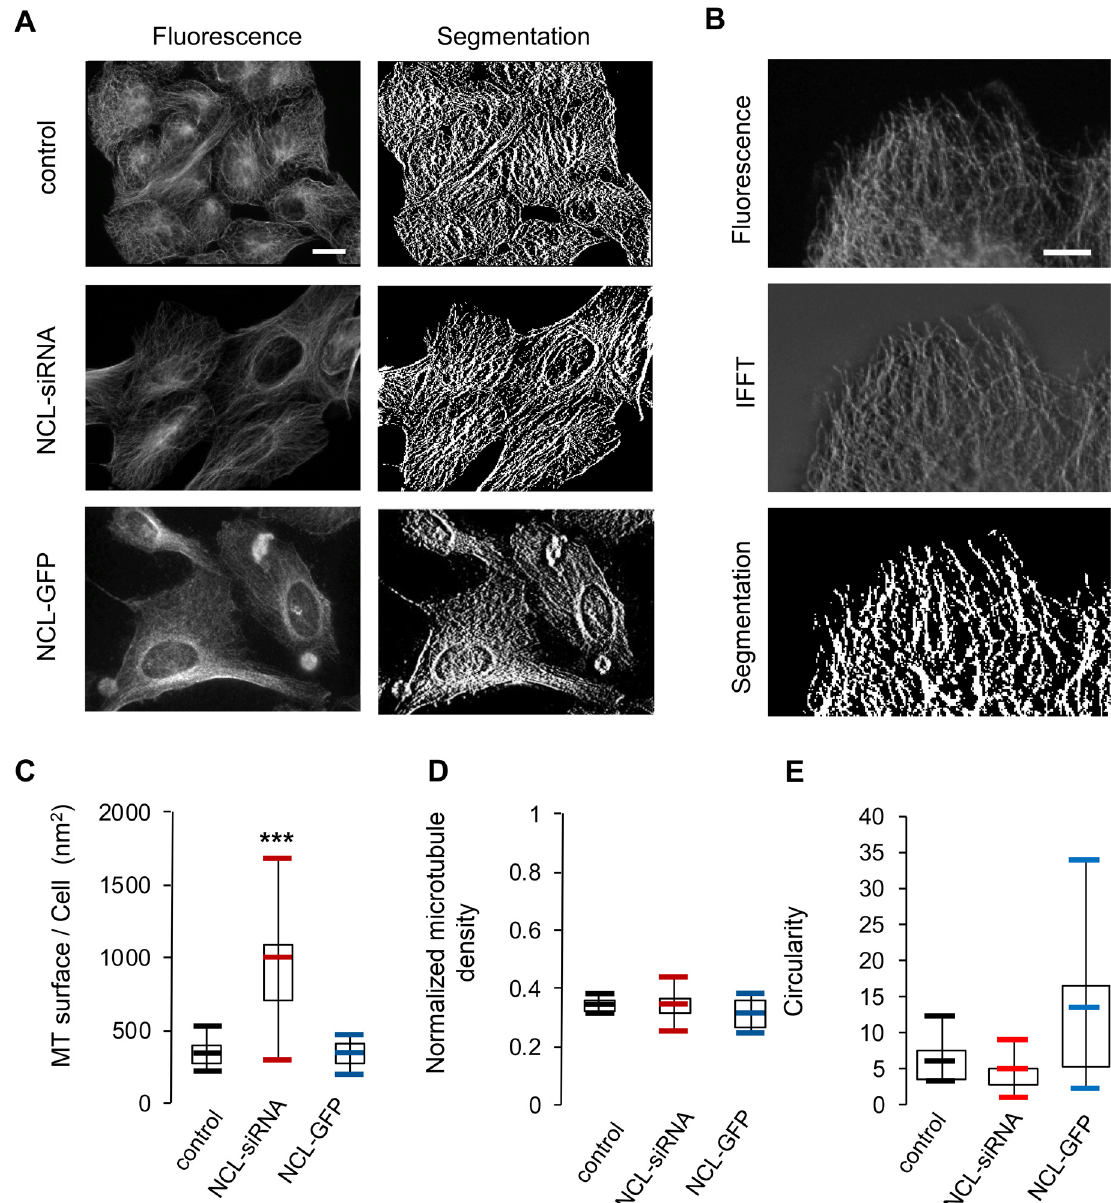
Fig 3. Nucleolin expression does not influence microtubules density. U2OS cells were either transfected with NCL-siRNA or NCL-GFP plasmid and after 4 days were fixed for tubulin immunofluorescence detection (A). The first column shows the immunofluorescence picture of the best focus image among the z-stack. The second column shows the segmentation picture. (B) Details of one control cell showing the different steps of the analysis IFFT: Inverse Fast Fourier Transform. Scale bars represent = 10 μ m. (C) Quantification of the microtubule surface per cell for control, NCL-siRNA and NCL-GFP cells. The asterisks indicate that the mean value differs from the control condition with the Wilcoxon-Mann-Whitney two-sample rank test at 0,5% ( *** P < 0.005). Cells were individually analyzed (control: 7 cells; NCL-siRNA: 21 cells; NCL-GFP: 8 cells). (D) Quantification of the microtubule density obtained by dividing the microtubule surface by the whole cell surface for control (7), NCL-siRNA (21) and NCL-GFP (8) cells. (E) Quantification of cell circularity for control (35 cells); Nucleolin-siRNA (32 cells) and NCL-GFP (45 cells). ( ** P < 0.05)